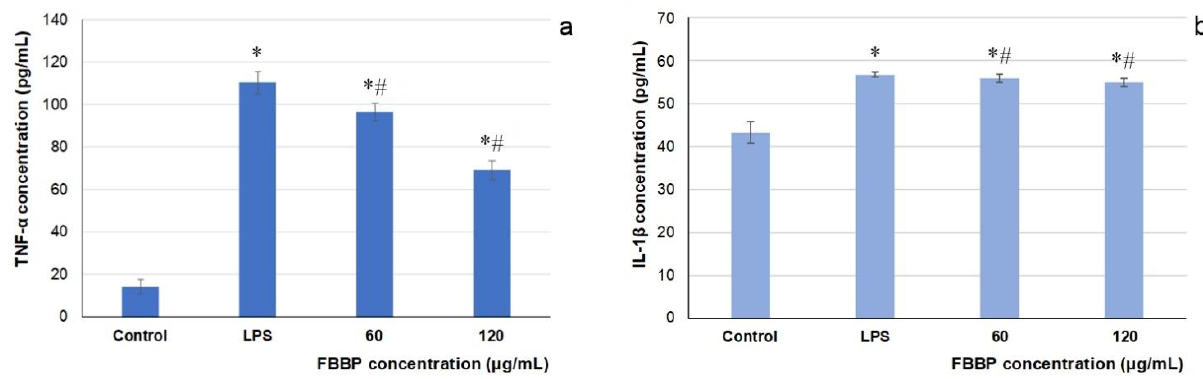
Figure 6. Secretion of TNF- α ( a ) and IL- 1β ( b ) pro-inflammatory cytokines in LPS-inflamed THP-1 macrophages pretreated with different concentrations of FBBP, determined by ELISA assay at 24 h of cultivation. * p < 0.05, compared to untreated cells (control); # p < 0.05, compared to LPS-inflamed cells.